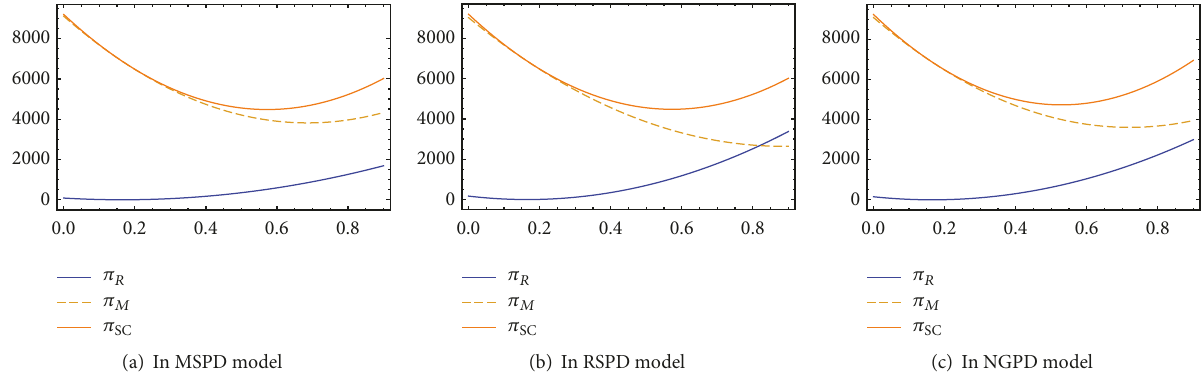
Figure 6: The change of expected profits with the parameters 𝜃